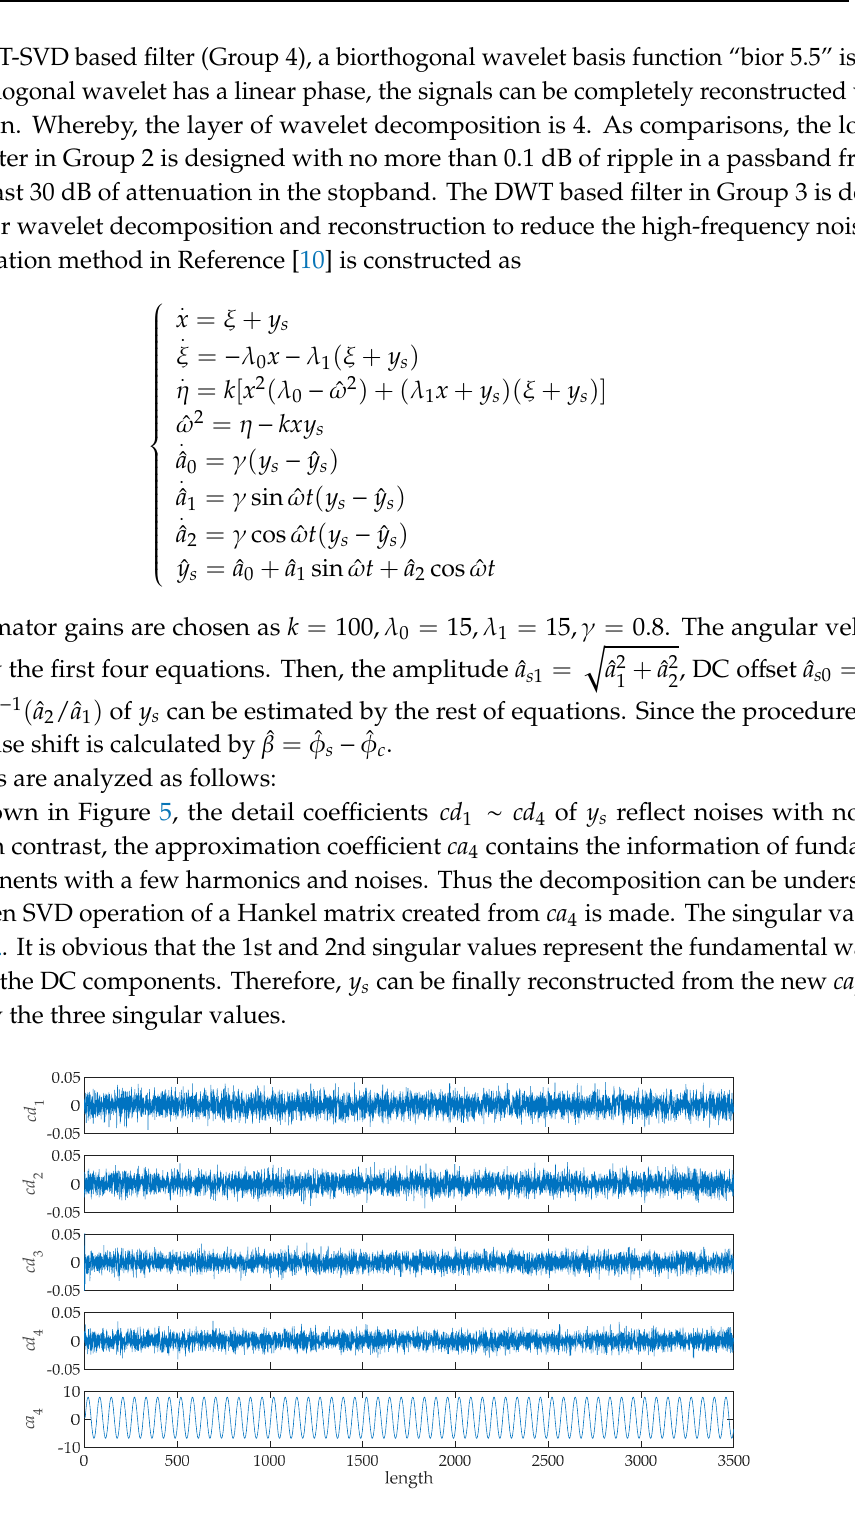
y in simulation. Figure 5. The first 3500 data of approximation coe ffi cient and detail coe ffi cients of y s in s